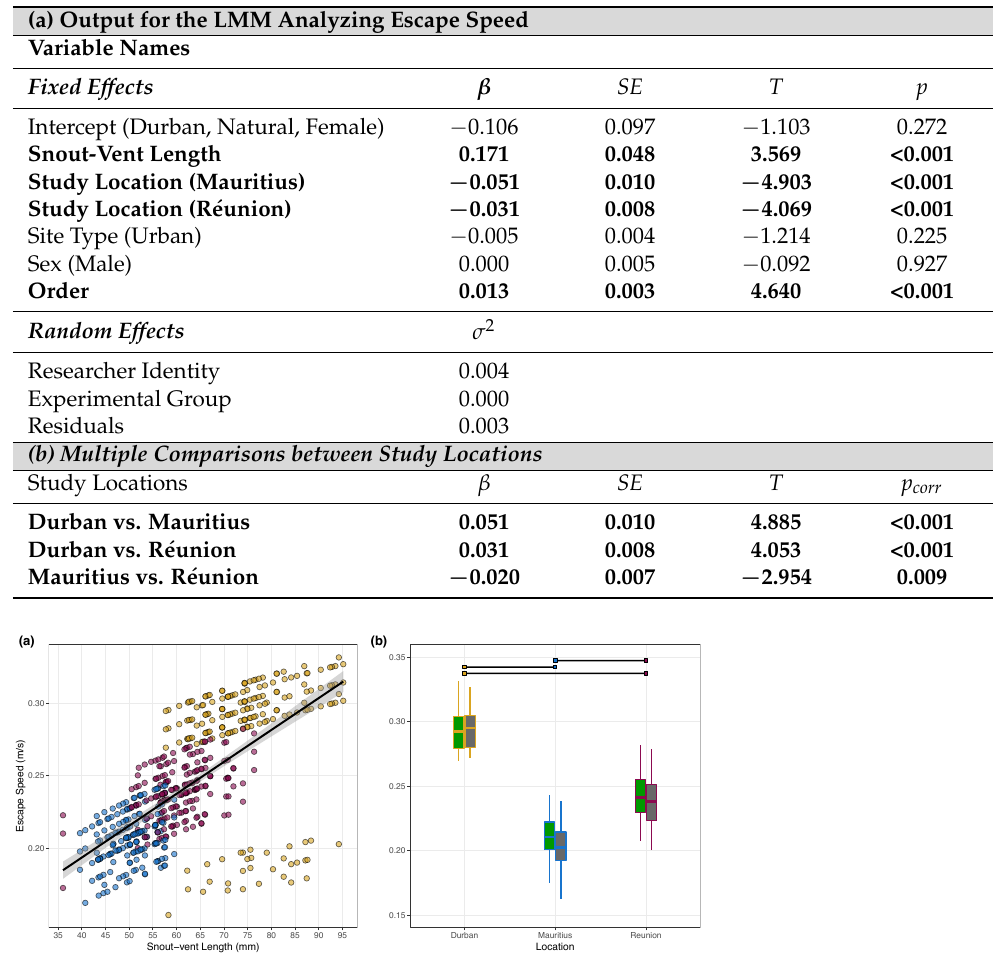
Figure 1. ( a ) Guttural toad ( Sclerophrys gutturalis ) escape speed (m/s) was significantly related to their snout-vent length (mm), which ( b ) translated into toads differing in their escape speed across study locations. On the left ( a ), the points are colored in yellow for toads from Durban, blue for toads from Mauritius, and burgundy for toads from R é union. A line of best fit, in black, is overlayed onto the plot. The gray sharing around the line of best fit shows the 95% confidence interval. Additionally, the data presented are predicted values from our LMM. On the right ( b ), we depict the raw data using boxplots to summarize the escape speed for each study location (i.e., Durban, outlined in yellow; Mauritius, outlined in blue; R é union, outlined in burgundy) and site type (i.e., natural sites, filled with green; urban sites, filled with gray). Significant differences are denoted using a black line with location-specific colors at the ends located above the boxplots. In the boxplots, the thick horizontal line represents the median, the boxes encompass the quartile ranges, and the whiskers represent the minimum and maximum data values, excluding outliers (points that are 3/2 times the upper quartile; not